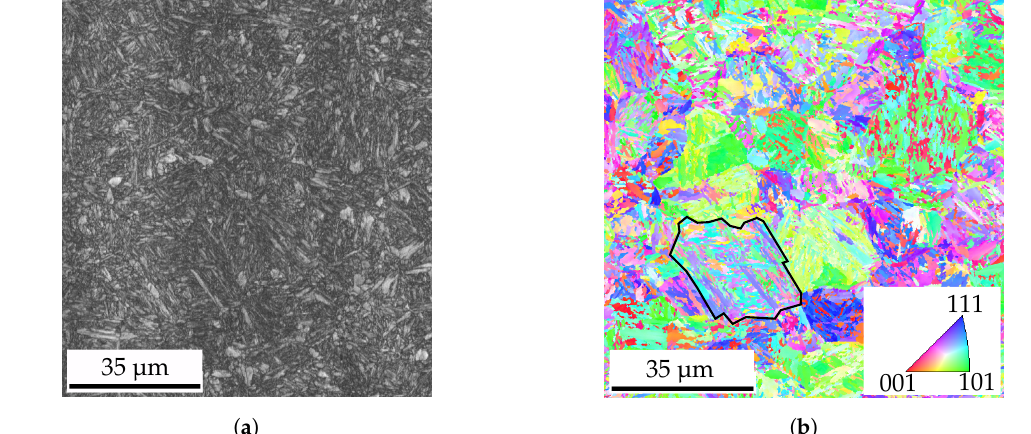
Figure 1. Experimental analysis of the SAE 4150 microstructure: ( a ) EBSD image quality map ( b ) EBSD map in inverse pole figure color